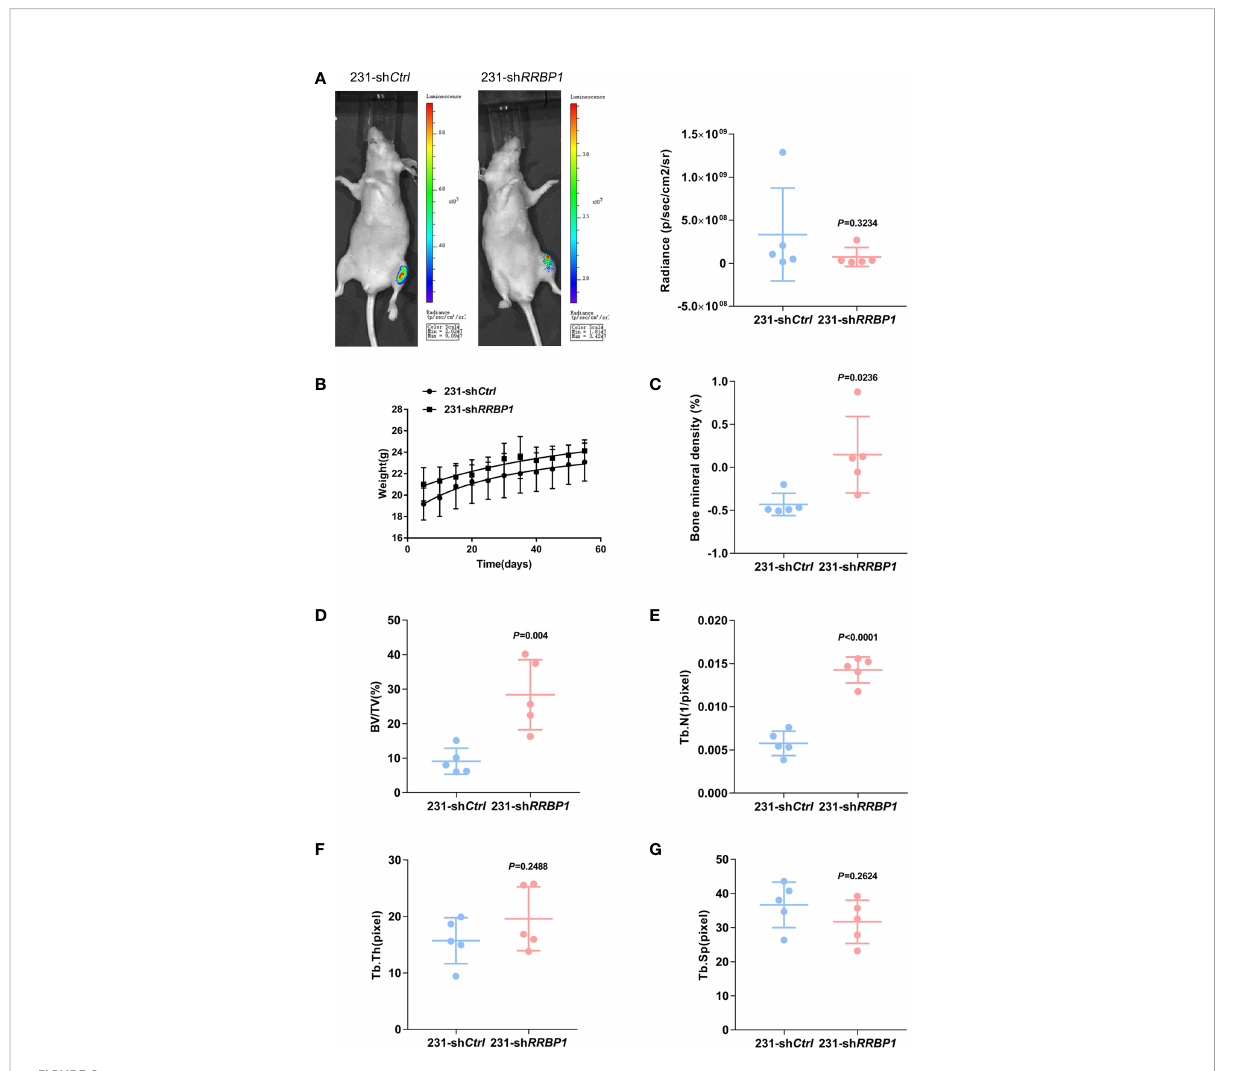
FIGURE 2 The effect of injection with MDA-MB-231 transduced with shRRBP1 into the proximal metaphysic of the tibia on bone mass in a nude mouse model. MDA-MB-231 cells transduced with sh RRBP1 were injected into the proximal metaphysic of the tibia in nude mice for 8 w. (A) The radiance (p/sec/ cm2/sr) of tumor mass was measured using the IVIS Lumin II in vivo imagining. (B) Mouse body weight was measured and analyzed using GraphPad Prism 6 software. (C – G) Quantitative analysis of structural parameters of the tibia by high-resolution micro-CT scanning: bone mineral density (C) , bone volume/total tissue volume (BV/TV) (D) , trabecular number (Tb. N) (E) , trabecular thickness (Tb. Th) (H) , and Trabecular Space (Tb. Sp) (G)